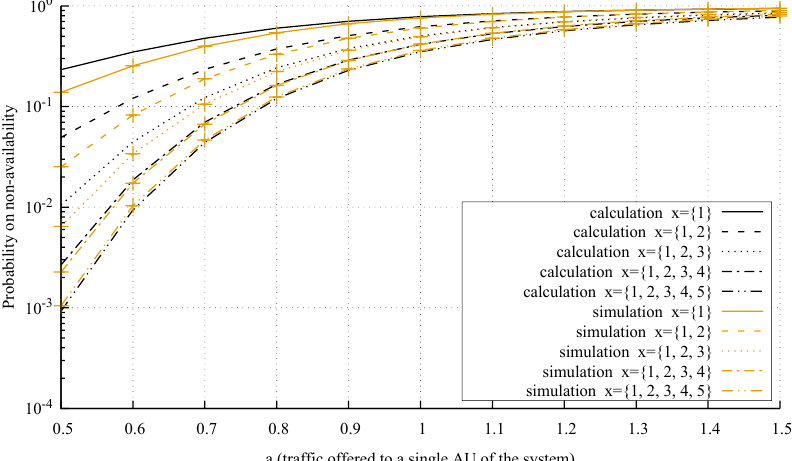
Figure 5. Probability of the non-availability of x strictly determined resources for class 2 calls ( t 2 = 2) in System 2, where x is the set of strictly determined resources in the limited-availability group.